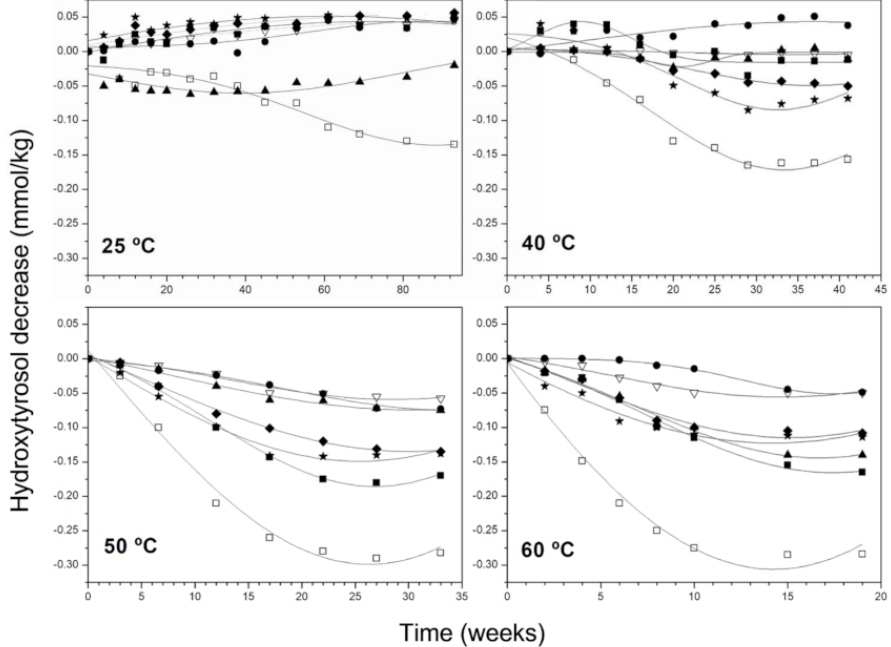
Figure 1. Decrease of hydroxytyrosol content in VOO samples at 25, 40, 50 and 60 ◦ C. Samples: (cid:4) , I; • , II; (cid:78) , III; ∇ , IV; , V; (cid:3) , VI; (cid:70) ,